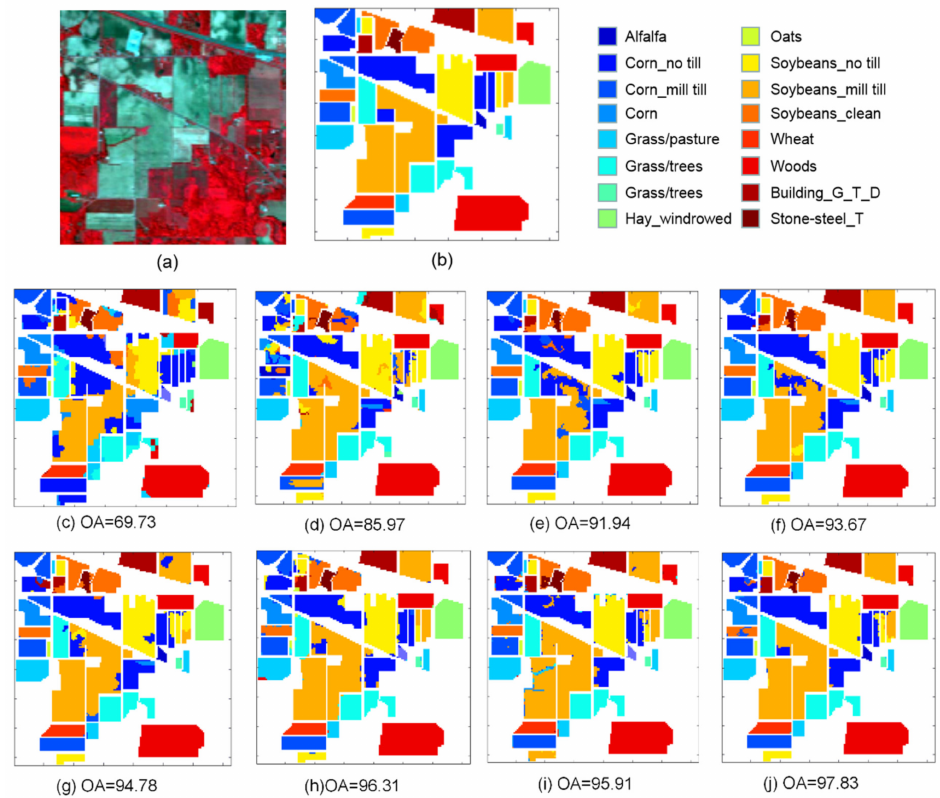
Figure 3. Indian Pines image. ( a ) The false-color composite image. ( b ) Ground-truth. The clas- sification maps of ( c ) GCN, ( d ) EPF, ( e ) IFRF, ( f ) SCMK, ( g ) SSL-SL, ( h ) MDGCN, ( i ) SPCNN and ( j ) SSG.